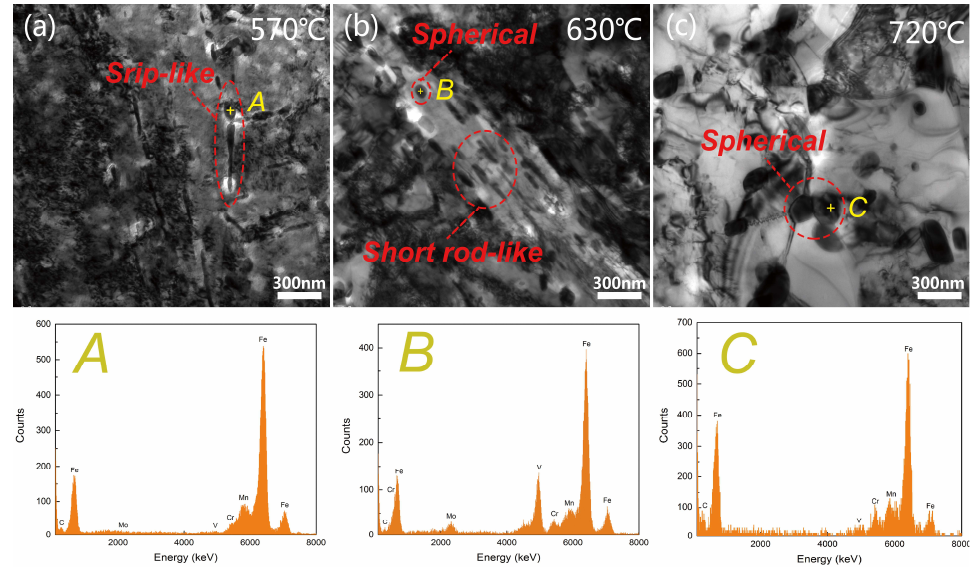
Figure 4. TEM and EDX results showing the evolution of carbides in 42CrMo4-V steel tempered at ( a ) 570 °C; ( b ) 630 °C; ( c ) 720 °C.